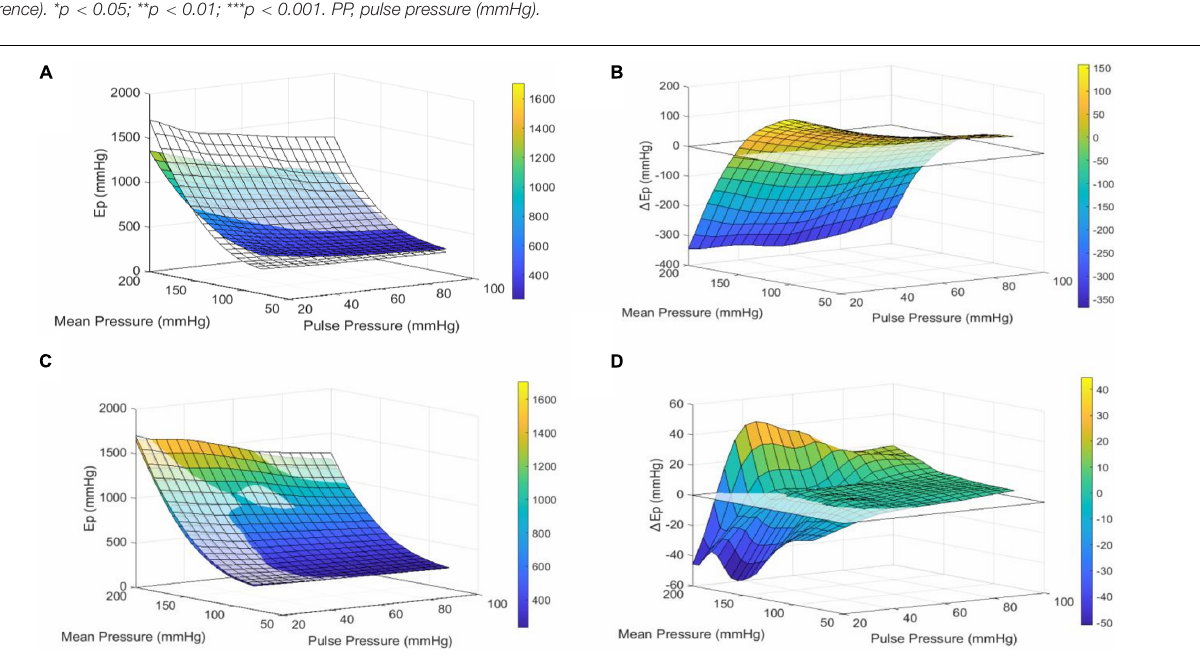
Data is expressed as (Mean ± SEM), n = 7. Repeated measures two-way ANOVA with Sidak post hoc test for multiple comparisons (comparisons are made with 40 PP as reference). *p < 0.05; **p < 0.01; ***p < 0.001. PP, pulse pressure (mmHg).